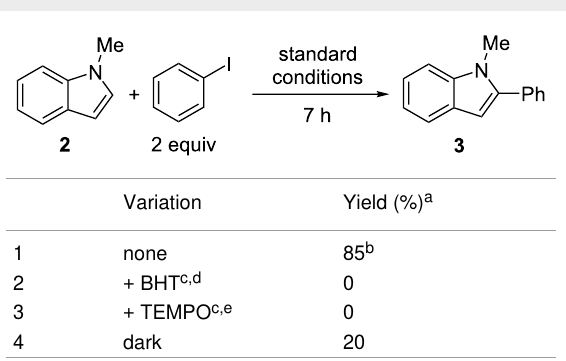
Table 2: Small molecule control